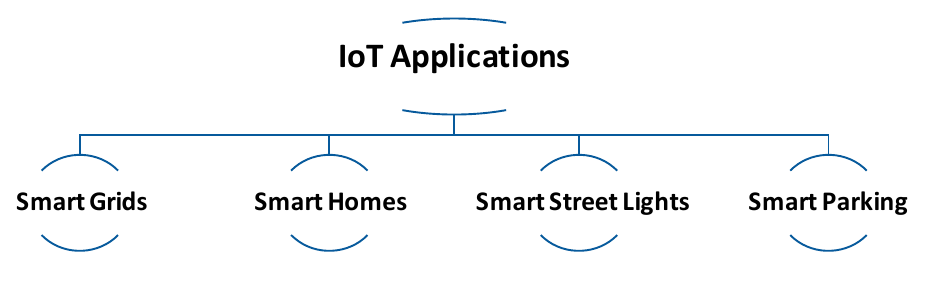
Figure 12. IoT applications for energy efficiency in smart cities.